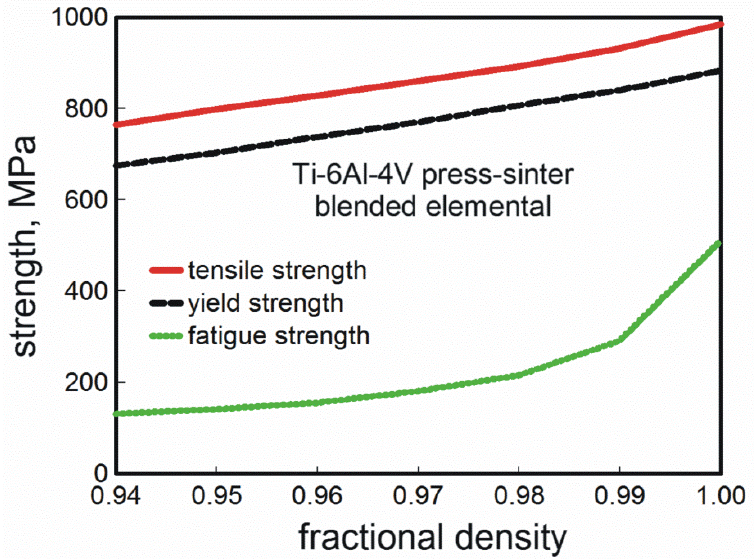
Figure 1. A plot of the mechanical properties for sintered Ti-6Al-4V from mixed powders versus fractional density showing the sensitivity of fatigue behavior as compared to tensile and yield